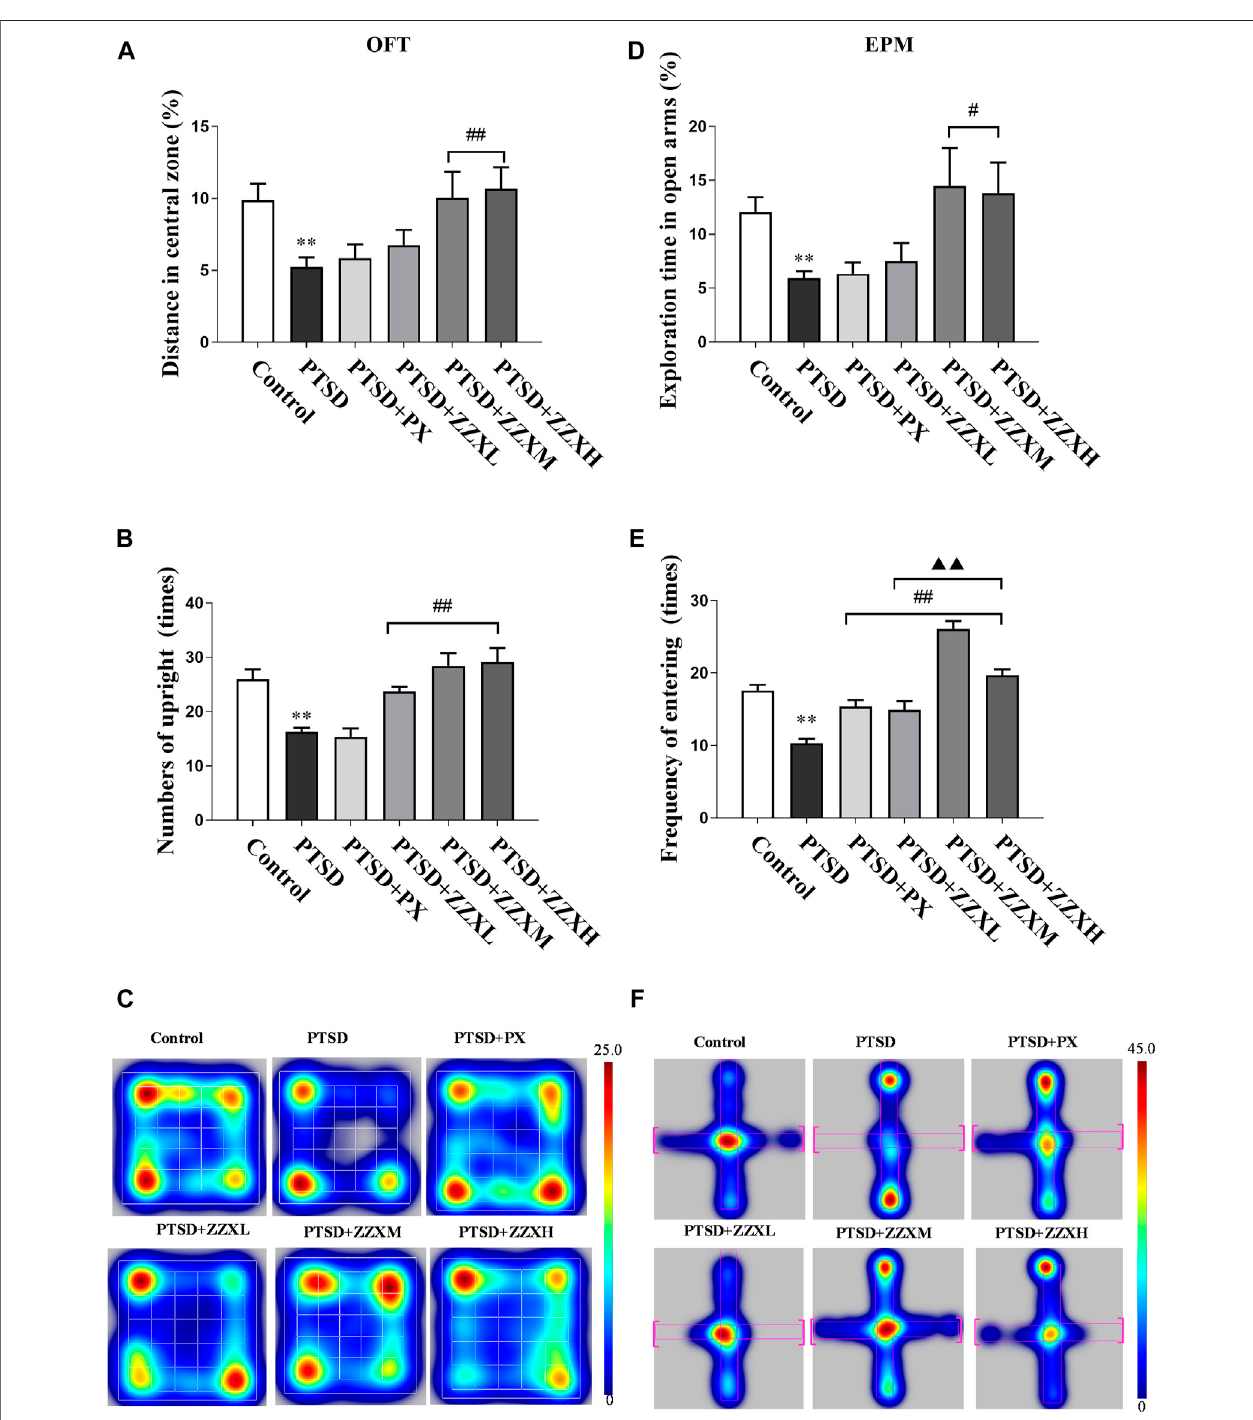
FIGURE3| EffectsofSPSandFSandZZXtreatment(40,80,120 mg kg − 1 )onOFTandEPM. (A) Distanceincentralzone; (B) numbersofupright; (C) heatmapof thetrajectoryofanindividualmouseovera5-mintestingsessionintheOFT; (D) explorationtimeinopenarms; (E) frequencyofentering; (F) heatmapofthetrajectoryof an individual mouse during the EPM. The horizontals refer to open arms, and the verticals refer to closed arms. Values are expressed as (mean ± SEM, n (cid:2) 10 – 15). * p < 0.05, ** p < 0.01 vs control group. # p < 0.05, ## p < 0.01 vs PTSD group. ▲ p < 0.05, ▲▲ p < 0.01 vs ZZXM group.